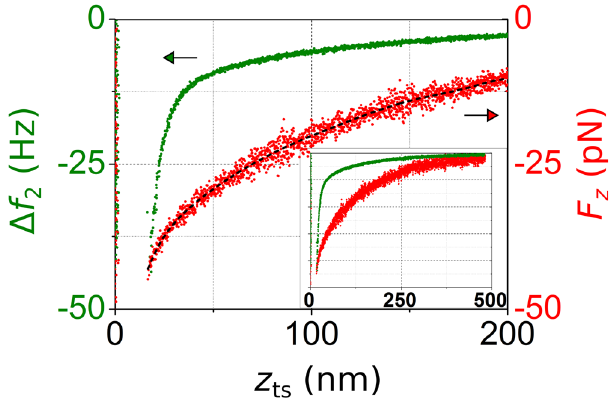
Fig. 8 Tip-sample distance dependent perpendicular force and frequency shift. Perpendicular force F z and Δ f 2 (frequency shift of the second fl exural mode) graphs measured by sequential distance sweeps with the arrows pointing to the respective axes ( F z measurement without any vibration excitation; second mode amplitude A 2 ¼ 4 : 8 nm during Δ f 2 data acquisition with free vibration resonance frequency f 2 ¼ 33740 Hz). The inset covers the full z ts sweep